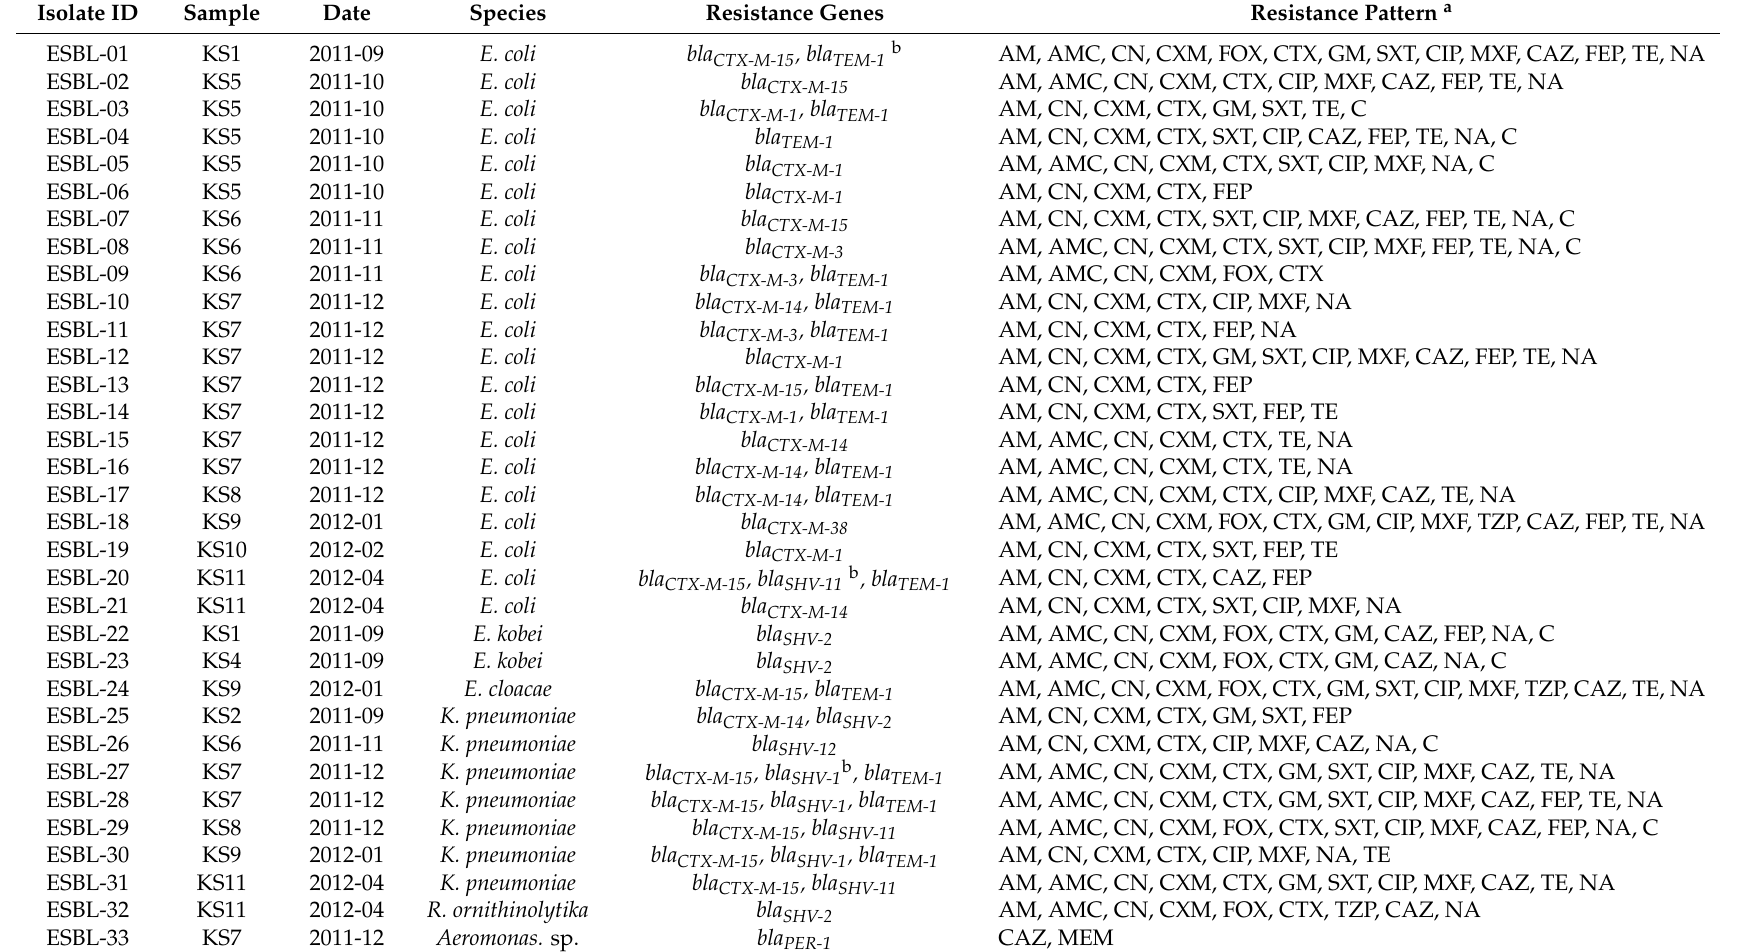
Table 1. Detected resistance genes and resistance pattern of all isolates. Non E. coli Enterobacteriaceae are automatically set resistant to AM according EUCAST. Isolate